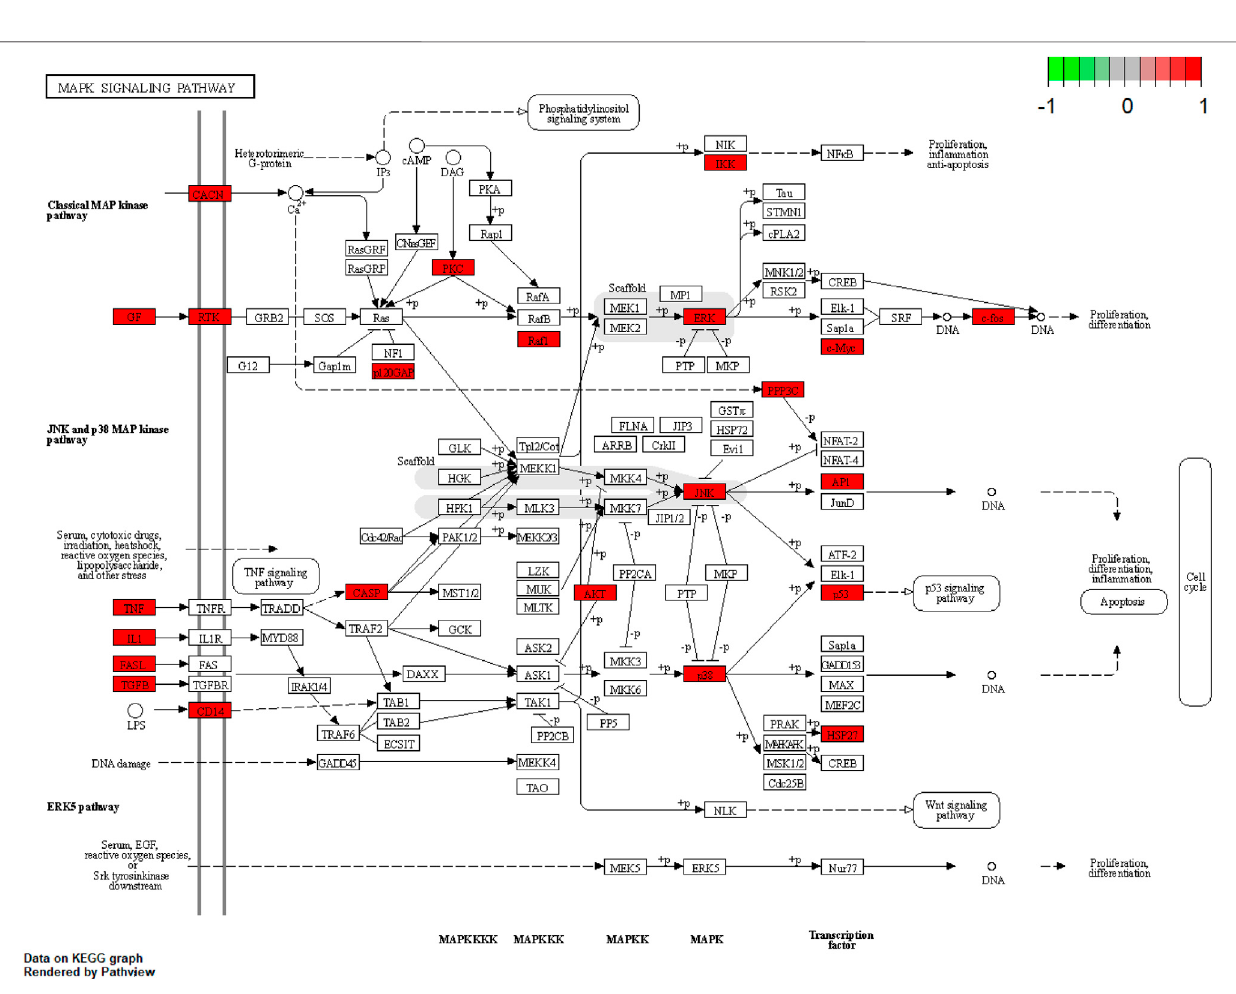
Frontiers in Pharmacology |